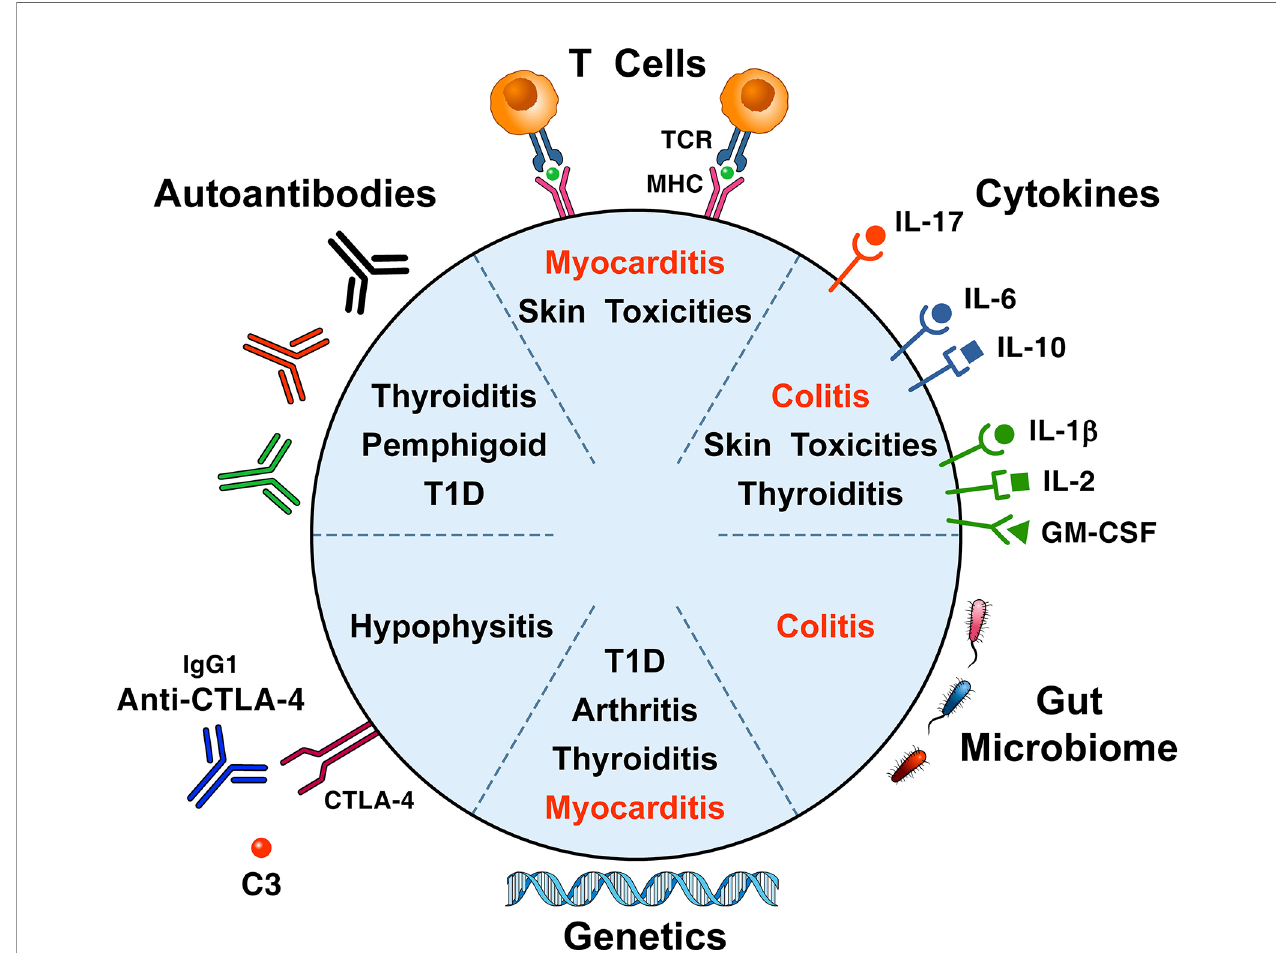
FIGURE 2 | Proposed immunopathogenic mechanisms for the development of immune checkpoint-induced immune-related adverse events. A proposed mechanism postulates that self-antigens (e.g., heart and skeletal muscle antigens) activate T cell clones driving antitumor responses and organ-speci fi c autoimmunity (24). Thyroid autoantibodies may be involved in patients who develop thyroid dysfunction (44, 59, 60), ICI-associated diabetes (42, 43), bullous pemphigoid (61), hypophysitis (62, 63), and myasthenia gravis (64). Cytokines/chemokines released from immune cells can cause immune-mediated tissue damage (12, 65, 66). The pivotal role of genetic factors in the development of ICI-associated irAEs, originally highlighted in mice (67, 68), has been con fi rmed in patients with arthritis (69), ICI- associated diabetes (42, 43, 70), and pruritus (71). There is growing evidence that gut microbiome may play a role in the development of experimental irAEs (72, 73) and of colitis in patients with melanoma (74, 75). irAEs contributing to most fatalities are presented in